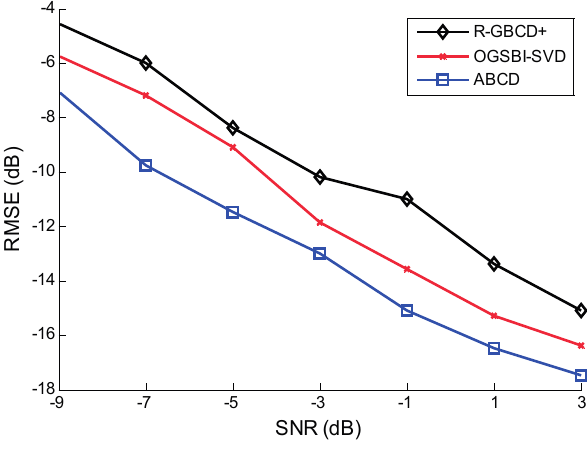
Figure 3. Success rates vs. number of snapshots with the fixed SNR 0 dB.